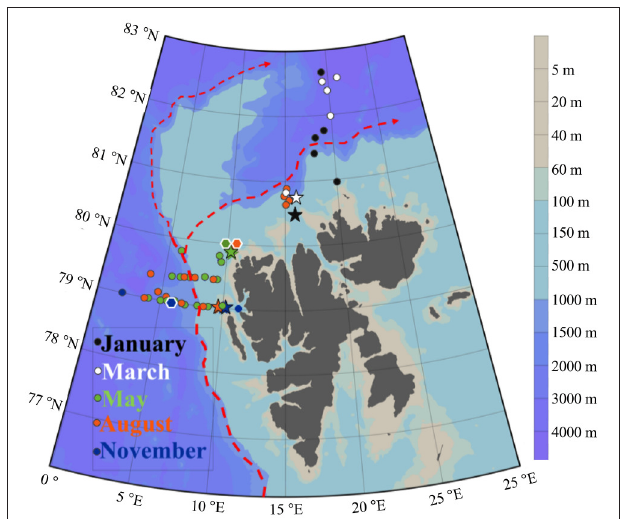
FIGURE 1 | Study area Northwest of Svalbard. Sampled stations are colored according to the month of sampling: January (black), March (white), May (green), August (orange), and November (blue). Star-symbols indicate sampling of water for fractionated growth experiments. Hexagon symbols with white border indicate sampling for molecular analysis. Red arrows indicate the main flow of the West Spitsbergen Current drawn after Cokelet et al. (2008), Randelhoff et al.